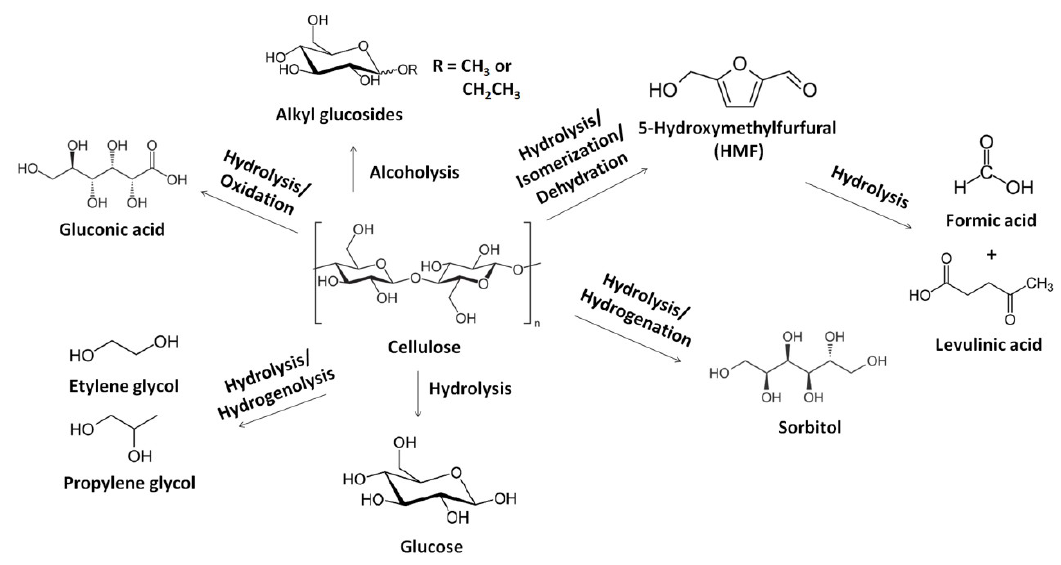
Figure 1. Typical platform chemicals produced from the catalytic transformations of cellulose.